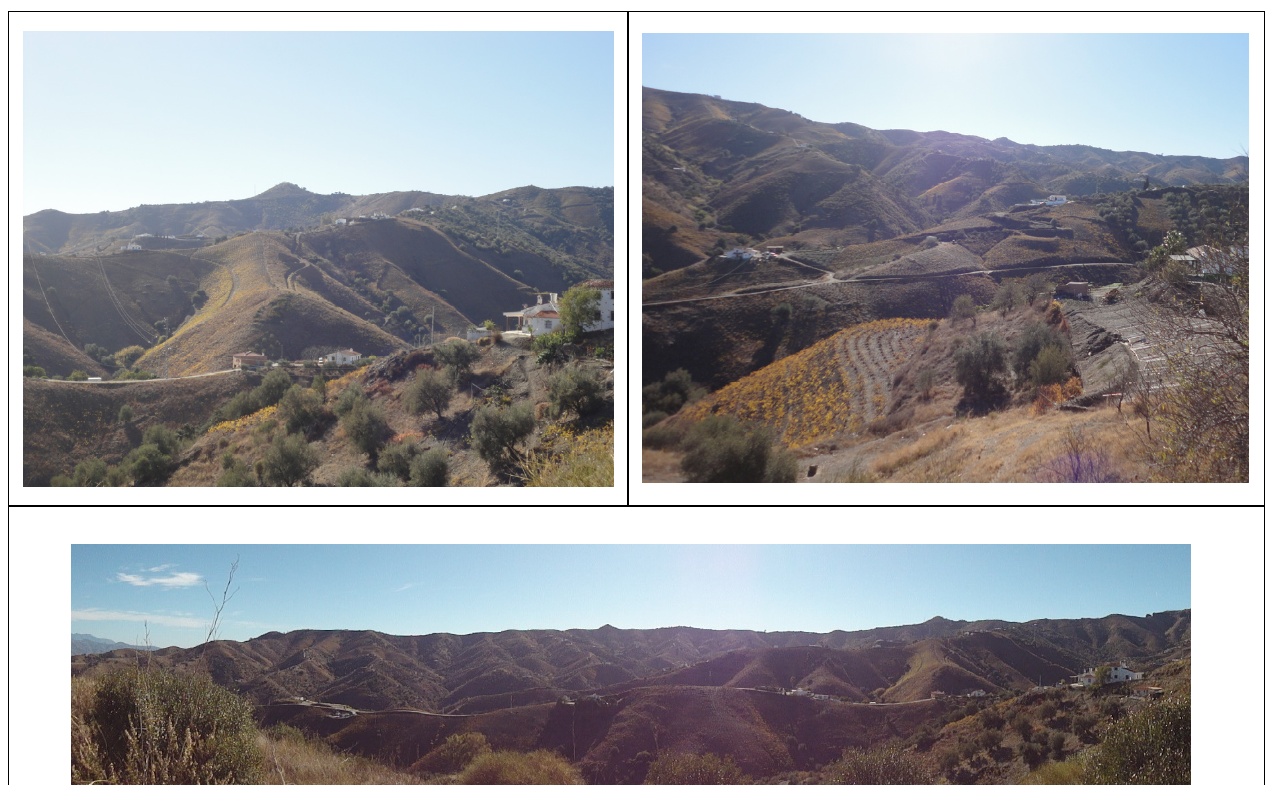
Figure 6. Vine-covered landscape in La Axarquía. Source: Authors. History has yielded an exceptional agricultural landscape: suntraps covered in leafy green vines with unique local architecture of traditional paseros and lagares scattered around the vineyards (Figure 7). As a whole, this is a landscape of highly diversified mid-height Mediterranean mountains: a mosaic of vineyards and orchards dotted among ploughed fields, pastures, and natural brush; Andalusian ‘white villages’; and an interstitial habitat of modest farm estates (with the characteristic paseros and lagares ).